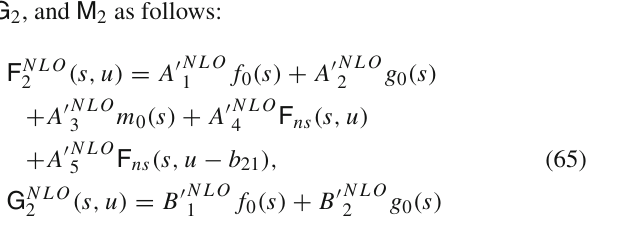
By solving Eqs. (59)–(61), one can obtain the functions F 2 , G 2 , and M 2 as